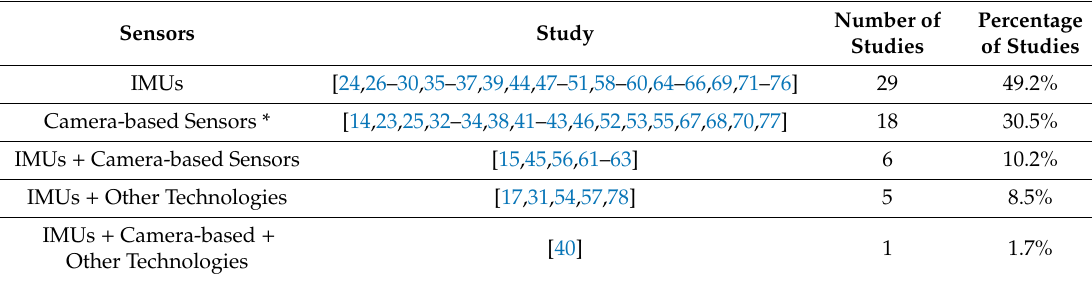
Table 3. Sensors used in the reported studies.